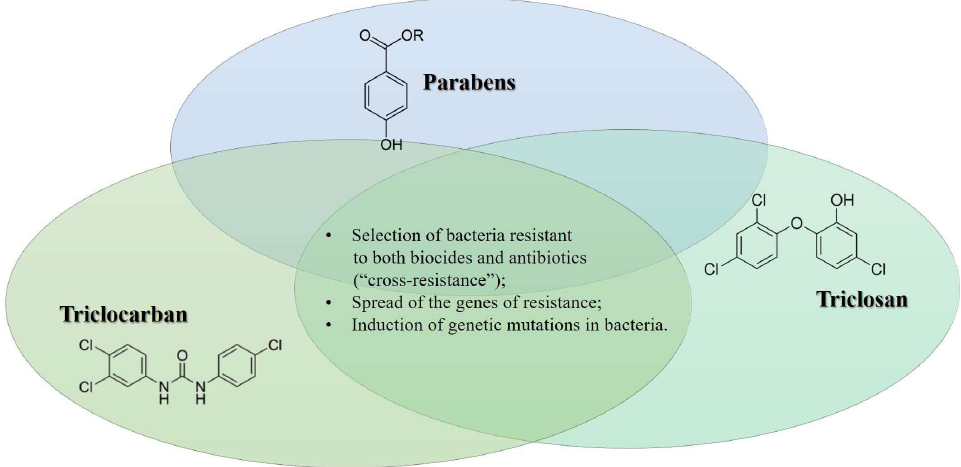
Figure 1. Biocide and the onset of antimicrobial resistance: summary of the main mechanisms.